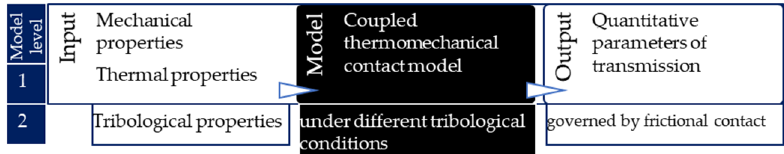
Figure 2. Schematic figure of the model for which input parameters are to be identified.